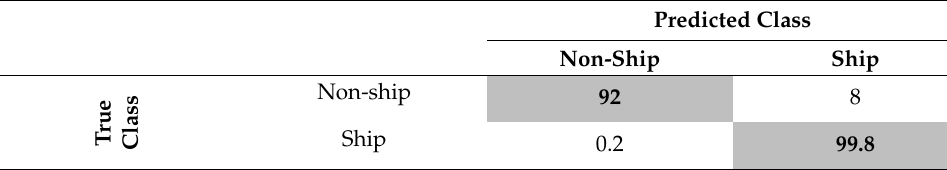
Table 8. The confusion matrix of the detection stage (values in